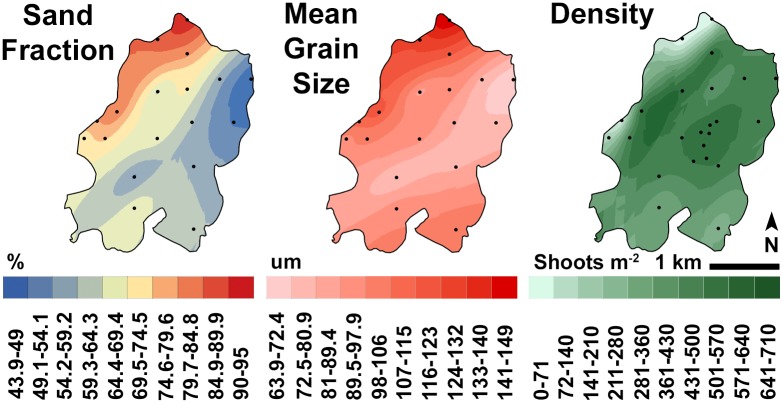
Meadow grain size (mean and sand fraction) and peak seagrass shoot density distributions.Sample sites are shown in each Fig; the maps were generated by kriging. Note that the inverse of sand fraction represents < sand-size particles.